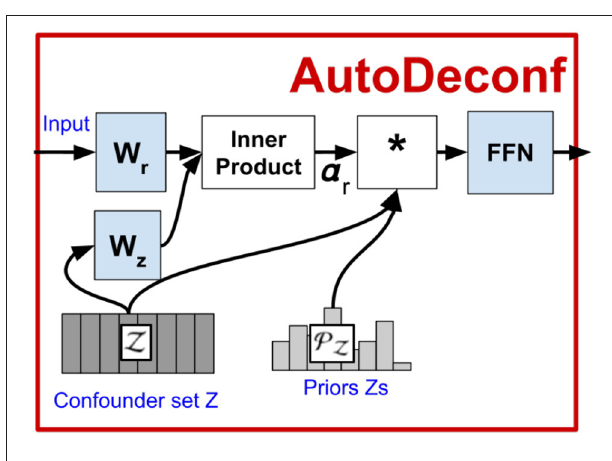
FIGURE 5 | Zoom-in of